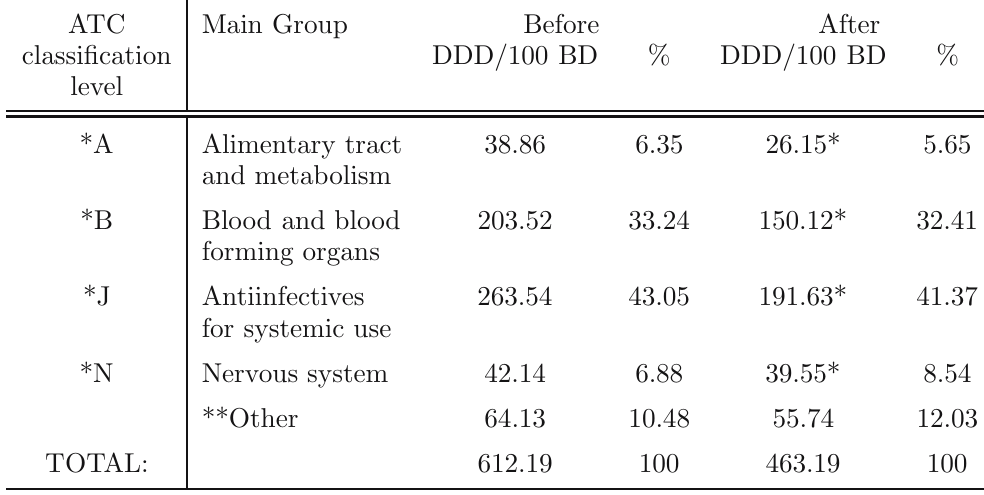
ward, Department of Surgery, University Clinical Center, Nis.